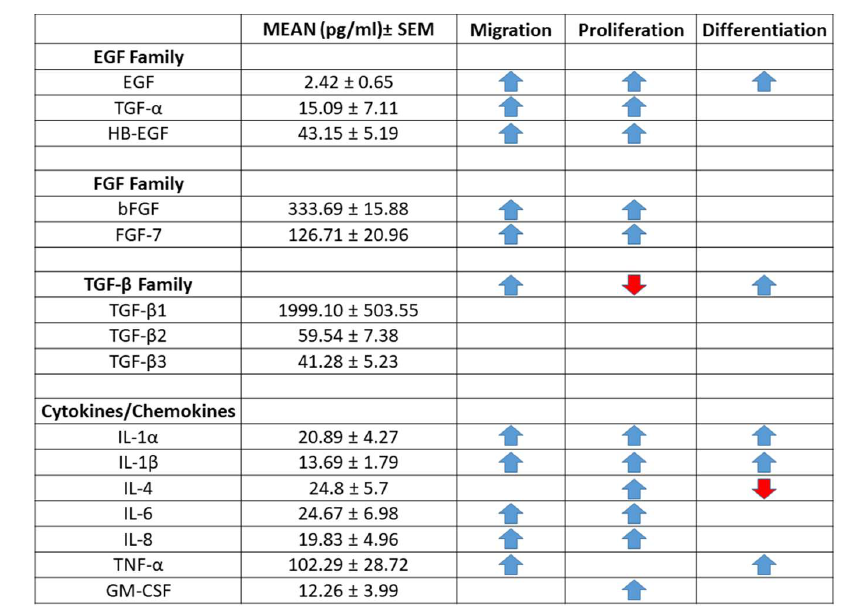
Figure 8. Quantification of cytokines, chemokines, and growth factors in human platelet-free plasma. Analysis of 200 proteins from three patient samples by Q4000 Quantibody ® revealed detectable levels of 176 proteins. A selection of proteins and growth factors related to migration, proliferation, and differentiation of keratinocytes are presented as mean ± standard error of the mean (SEM) in pg/mL. Arrow direction, increases (blue) or decreases (red), indicates the effect of the particular protein on either migration, proliferation, and/or differentiation of keratinocytes as reviewed in the literature [36–38]. 3. Discussion Acute wound care is a major socio-economic problem in the United States. If not appropriately treated, acute wounds may result in long-term healing complications, such as infection, contraction, and scarring, which negatively impact the quality of life of an individual [1]. According to the FDA, complete wound closure is defined as “skin re-epithelialization without drainage or dressing requirements confirmed at two consecutive study visits 2 weeks apart” [4]. From a clinical perspective, complete wound closure is considered ‘The Gold Standard’ to determine success of a treatment. A variety of next-generation biocompatible wound-healing materials, ranging from immediate temporary wound coverings to complete skin substitutes, with or without active pharmacological agents, are being developed [39–41]. It is essential to determine if any of these new wound dressings would meet the FDA standard of inducing successful and complete wound re-epithelialization. Therefore, there is a requirement to screen such products at a reproducible and faster pace by using an economically feasible and clinically valid experimental model. The focus of our current study was to investigate similar materials in a potential high-throughput model prior to investigation in more expensive pre-clinical large animal models. Here, we are exploring the effects of hydrogel-based biomaterials on wound closure using a human ex vivo full-thickness wound model. The currently developed ex vivo model closely mimics any acute injuries such as full-thickness skin abrasions or tears, deep cuts, or excised burn wounds. Hydrogel-based wound dressings currently have a significant impact on acute wound care due to their ability to provide a moist wound environment, adequate gas and fluid exchange, to support cell growth, and to be capable of delivering therapeutic drugs to the wound bed [42]. Three different hydrogel systems (i.e., collagen, PEG-fibrin, and PEG-PFP) were tested in this study. We initially screened these hydrogels using a 4 mm full-thickness excision wound model. The explants treated with the PEG-PFP hydrogels had a complete and multilayer epidermis. Specifically, the newly